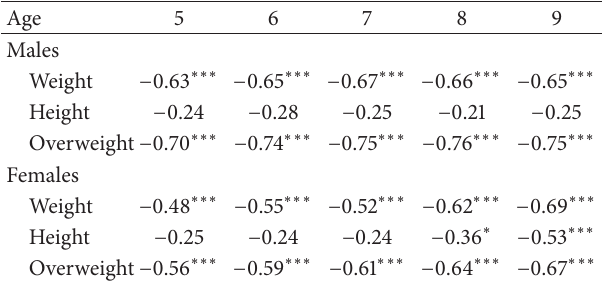
Table 4: Correlations between age at PHV and standardized weight, height, and prevalence rate of